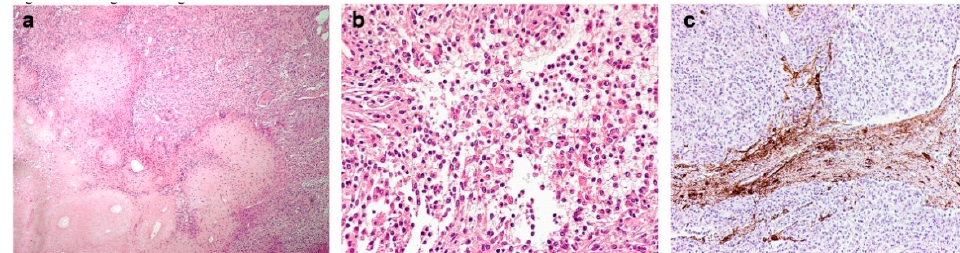
Figure 2. ( a ) The tumor was composed of cellular intersecting fascicles of spindle cells, alternating with hypo-cellular fibrous nodules of dense collagenous tissue (H&E, magnification 100 × ). ( b ) Some areas of rhabdoid cells were present (H&E, magnification 200 × ). ( c ) Immunohistochemistry for GFAP evidencing brain invasion (magnification 100 ×